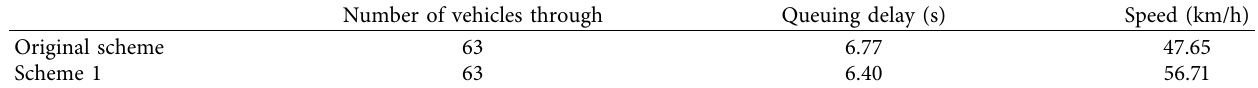
Table 4: Comparison between scheme 1 and the original scheme.